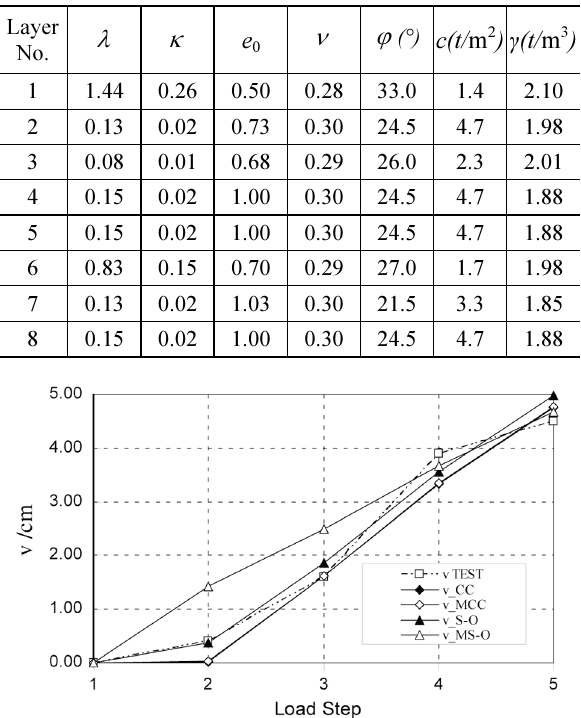
Table 2. Material parameters used in FEM analysis Layer